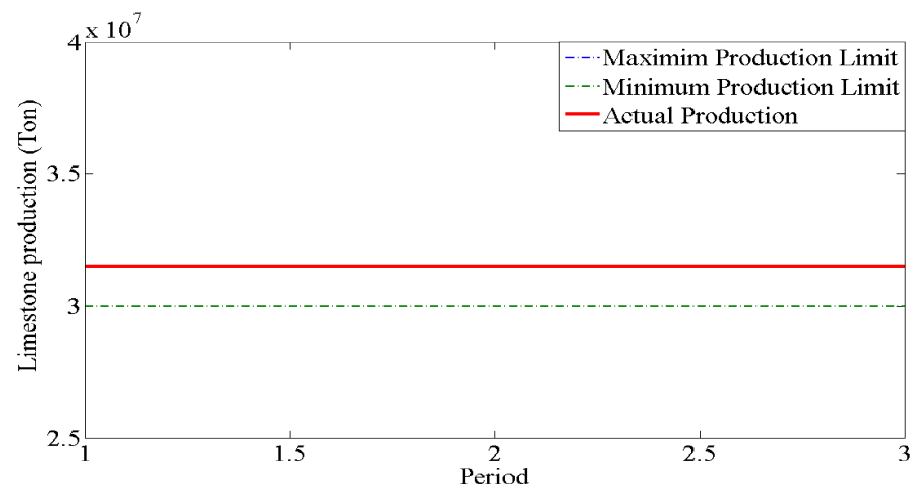
Figure 5. Model 1: limestone production with a production bound up to three periods.